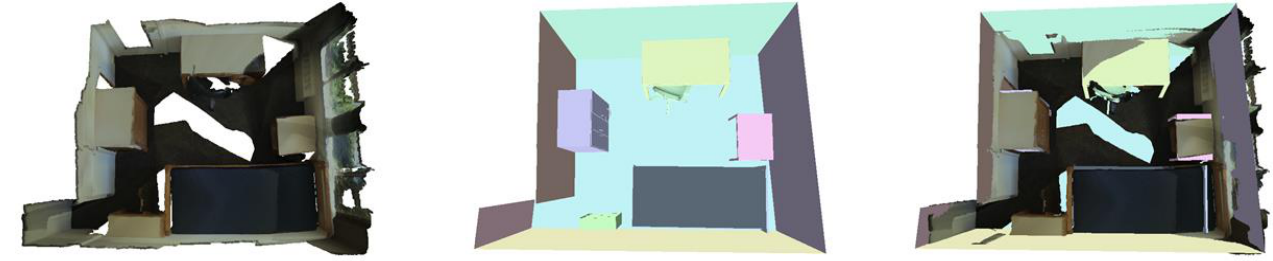
Figure 16. Overall reconstruction: ( left ) the original input point cloud, ( middle ) the reconstruction result, ( right ) the overlay of ( left ) and ( middle ).